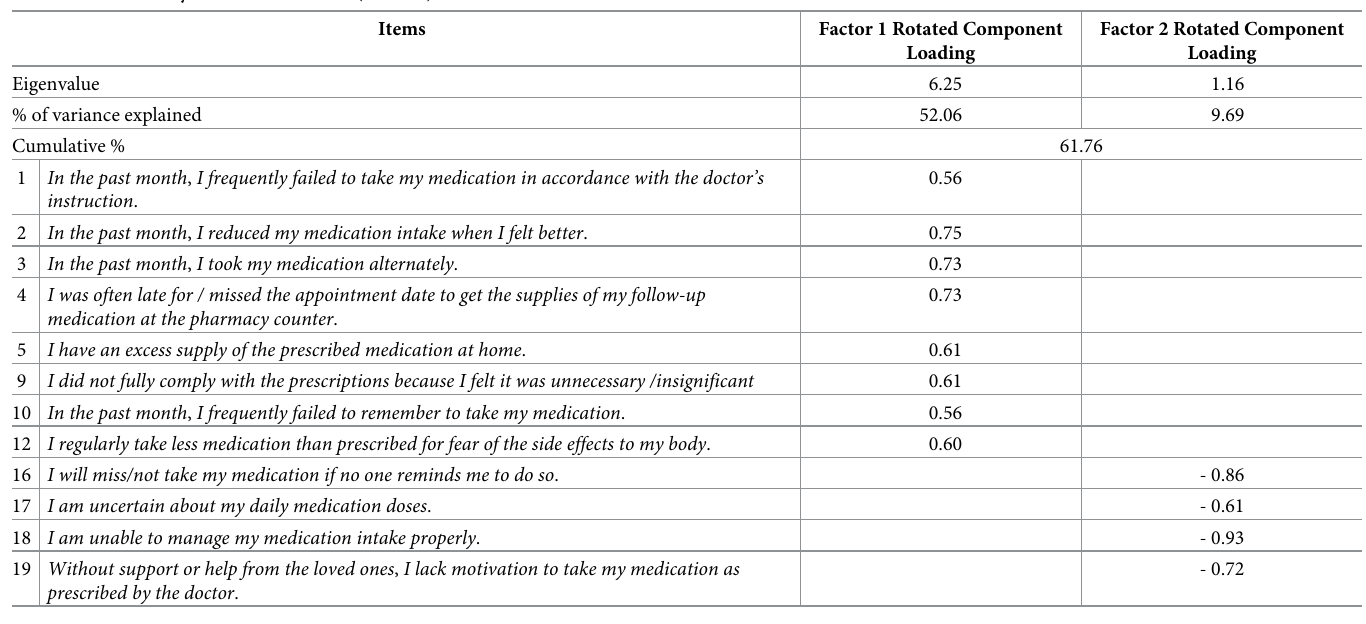
Table 4. Factor analysis of reduced items (2 factor).